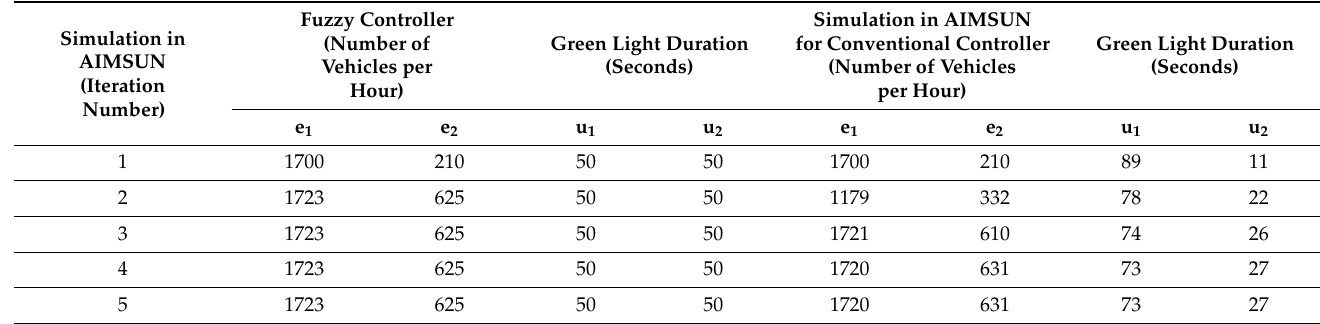
Table 2. Results of traffic simulation for junction 2.